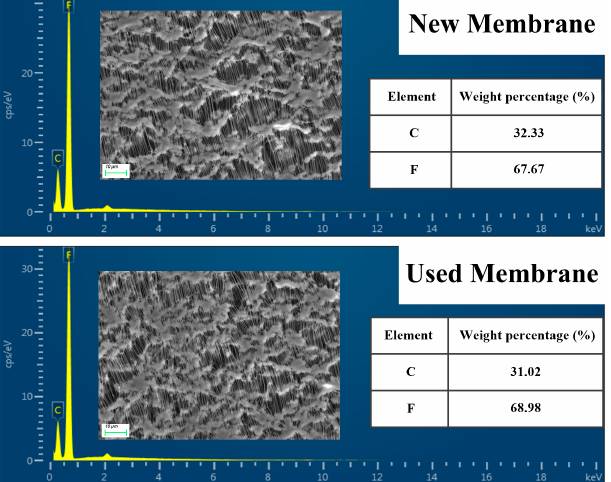
Figure 17. SEM and EDS analysis for the new and used PTFE membranes.